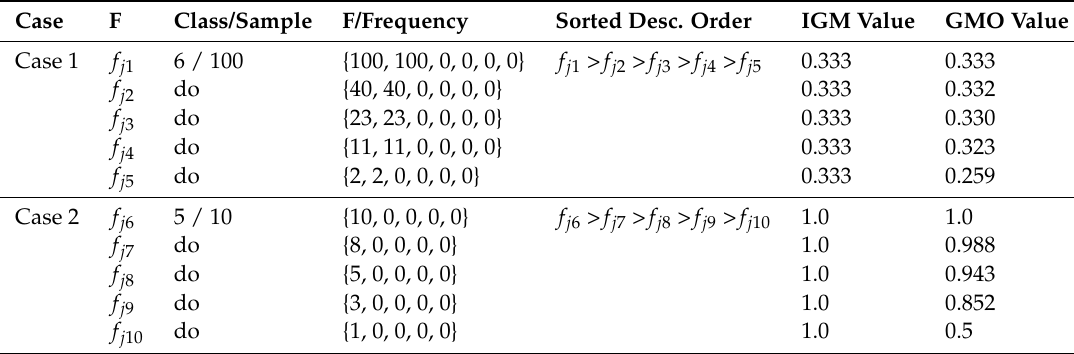
Table 1. Comparison between weights computed by IGM and